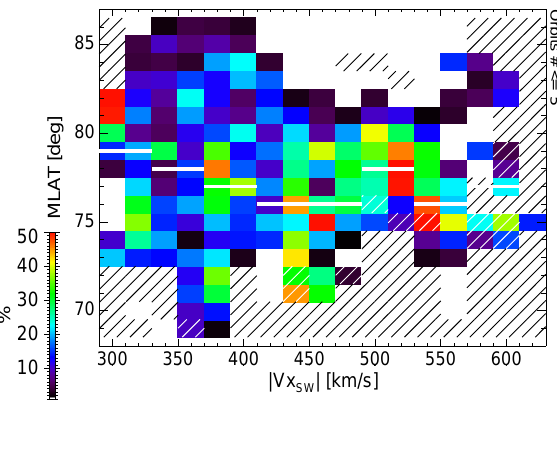
Fig. 8. The cusp latitudinal location as a function of the solar wind velocity v X